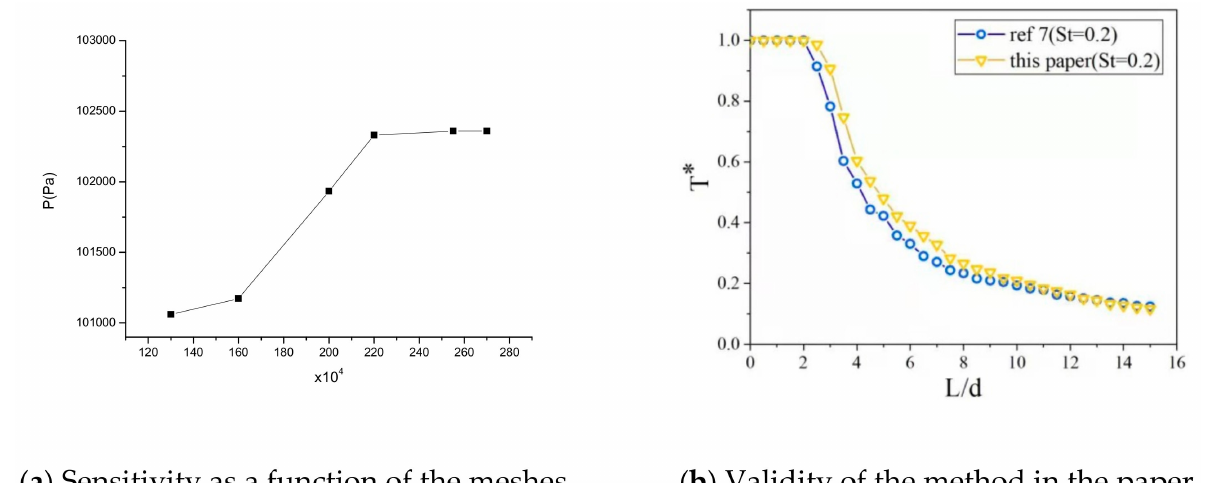
Figure 4. Validity of the meshes and numerical simulation method.